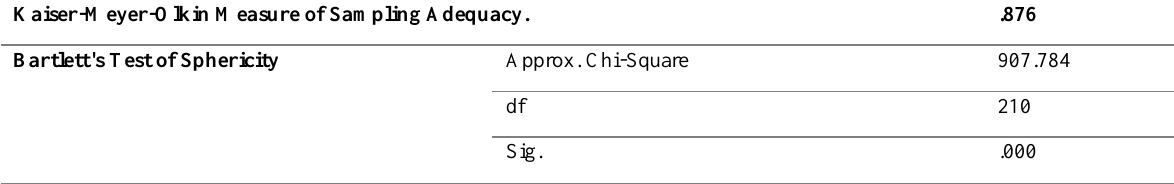
Table 7: Kaiser-Meyer-Olkin of the Workplace Bullying (n=45) Kaiser-Meyer-Olkin Measure of Sampling